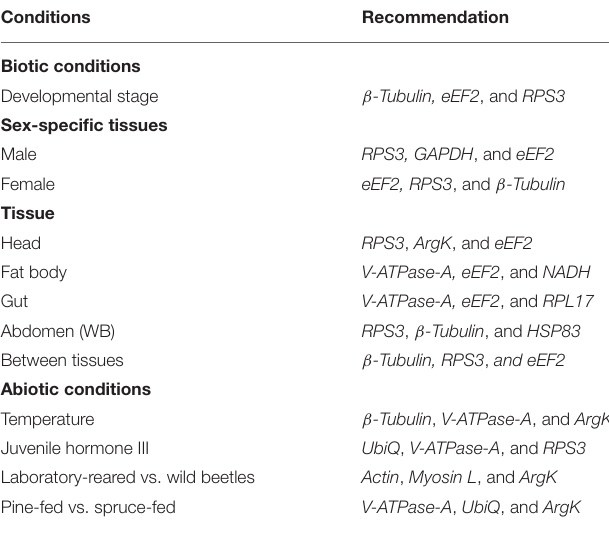
TABLE 6 | Summary of the recommended reference genes under different experimental